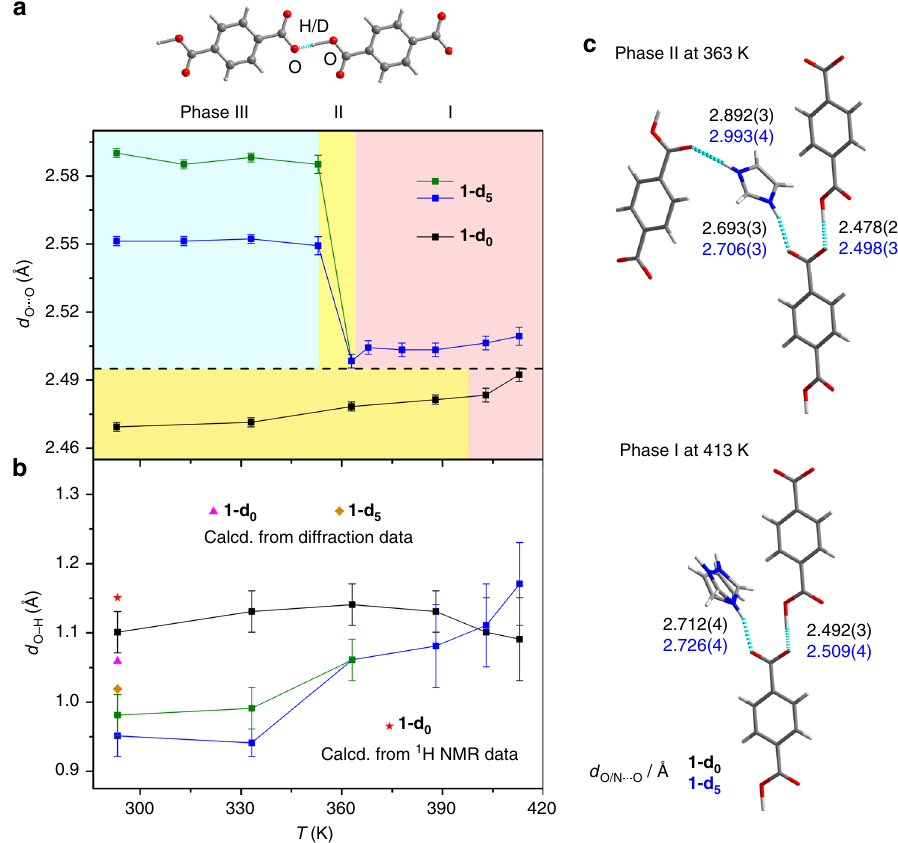
Fig. 5 GIEs on the O – H ··· O H bonds between two TPA anions in different phases of 1-d 0 and 1-d 5 . a Secondary GIE on the O ··· O distance ( d O ··· O ) (phase I, light pink; phase II, yellow; phase III, light cyan). Lines are placed to guide the eye. b Primary GIE on the O – H bond length ( d O – H ). The measured diffraction data are compared with the calculated values from either the diffraction data or the 1 H NMR data at 293 K, based on the equations and parameters published by Limbach et al 43 . The error bars in a and b are the estimated standard deviations (esds) calculated rigorously from the full covariance matrix. The esds in the bond lengths output by SHELXL take the errors in the unit-cell dimensions into account. c Local H-bonded con fi gurations of 1-d 0 and 1-d 5 in phase I (413 K) and II (363 K). Only the d O/N ··· O values are shown (black for 1-d 0 and blue for 1-d 5